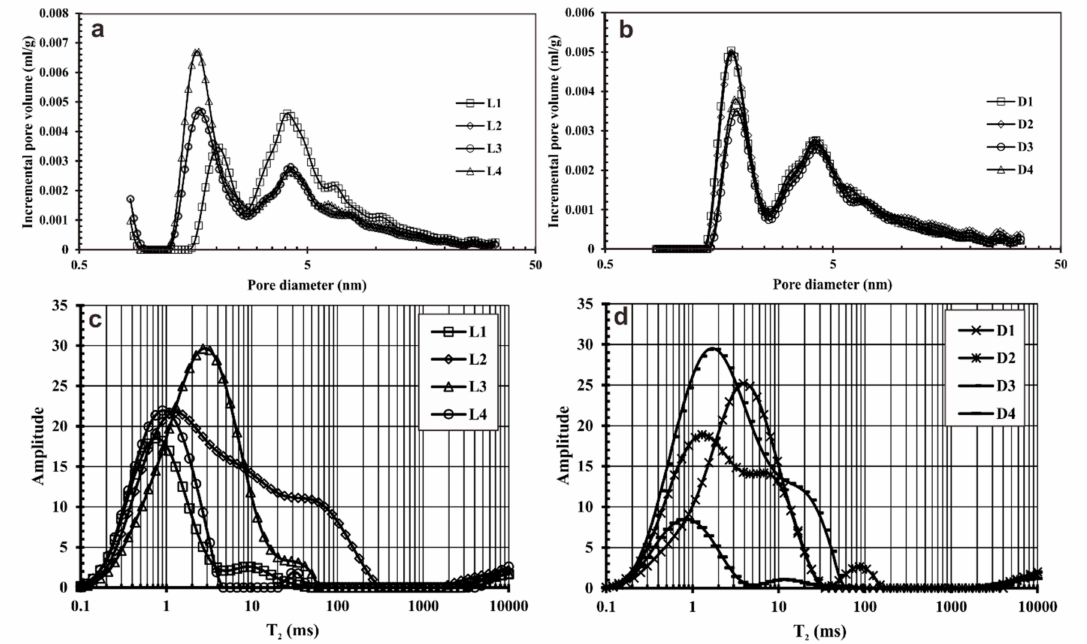
Figure 10. ( a , b ) Plots of pore volume versus pore diameter (nm) showing a distinct bimodal pore size distribution (PSD) within samples obtained from LPNA measurement. ( c , d ) NMR T 2 relaxation time curves of shale